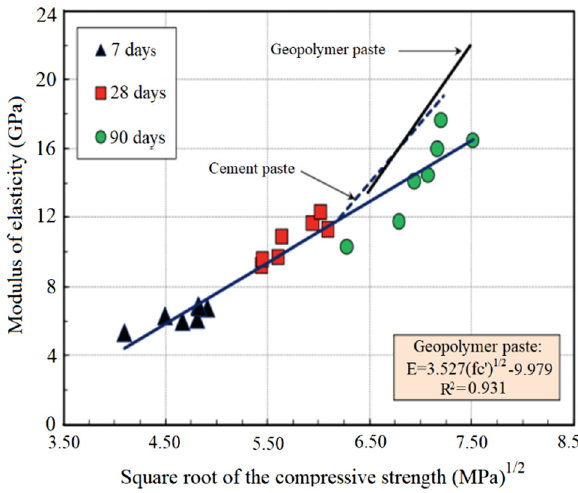
Figure 8: Relationship between compressive strength and fl exural strength of geopolymer pastes [ 41 ] .